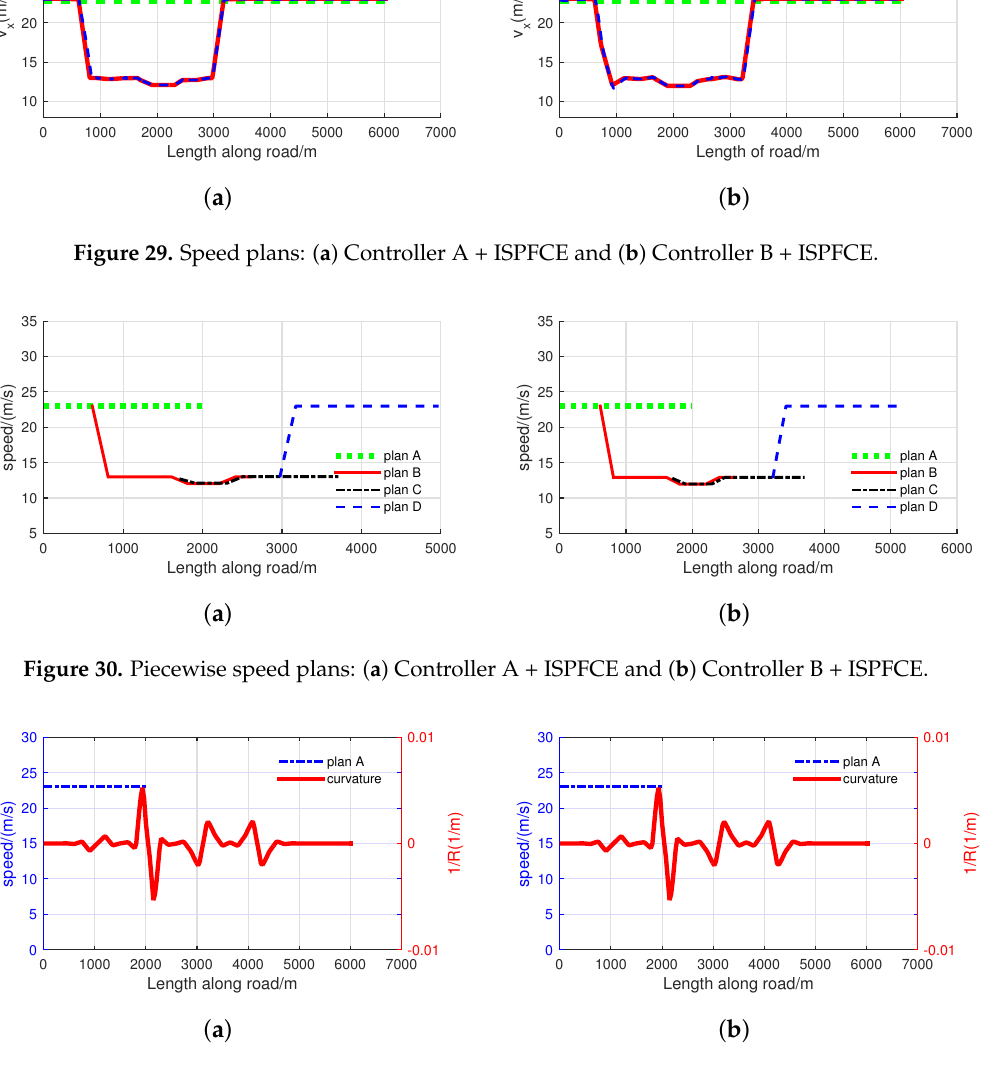
Figure 31. Speed Plan A: ( a ) Controller A + ISPFCE and ( b ) Controller B +